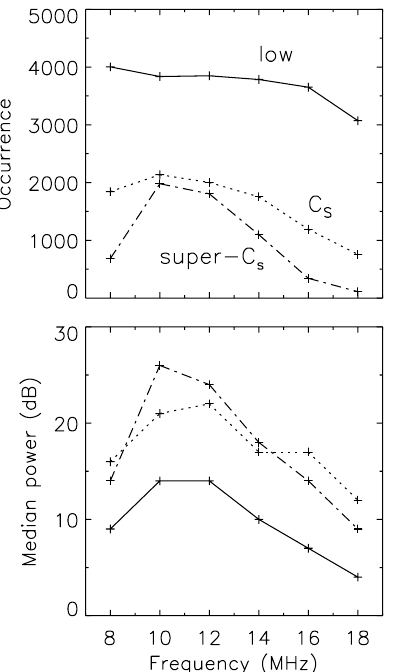
Fig. 7. Frequency variation of occurrence (top panel) and median power (bottom panel) of the low Doppler shift, C S and super- C S echo